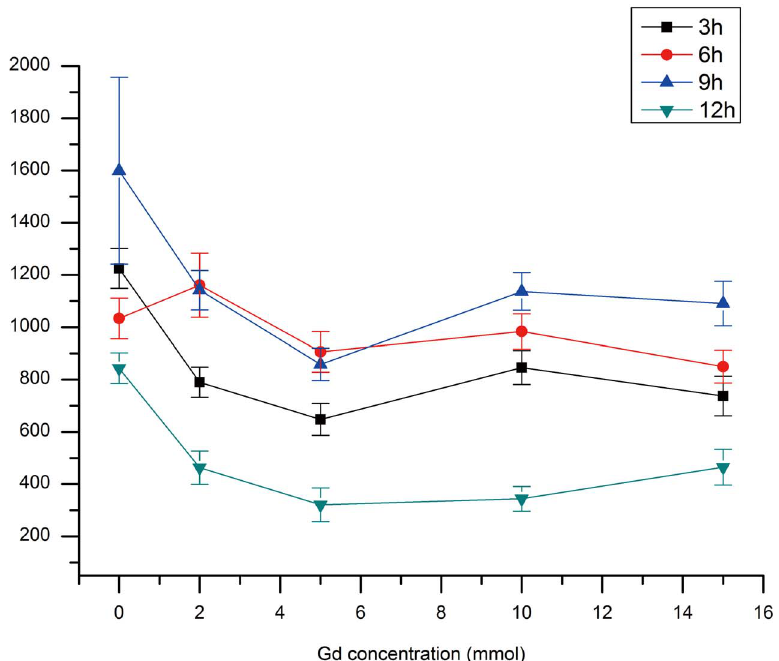
Figure 5. Spin-lattice relaxation times (T1) of root samples that treated with different concentrations of Gd-DTPA at different time points.